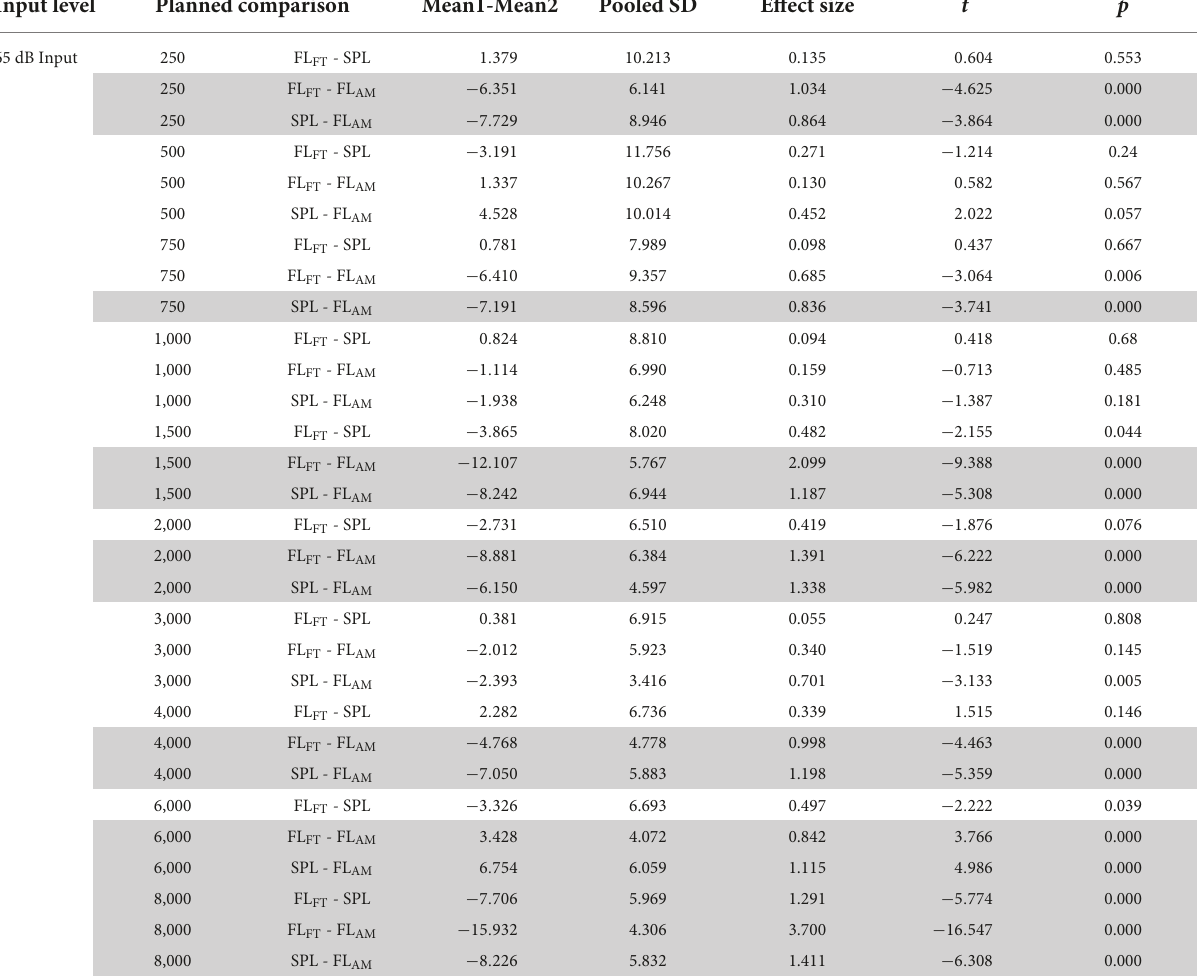
TABLE 2 Results from the t -test showing the p -values when comparing the audibility in 65 dB SPL input for the differences between the three measuring methods (FL FT represents the force transducer method, SPL represents the ear canal method, and FT AM represents the artificial